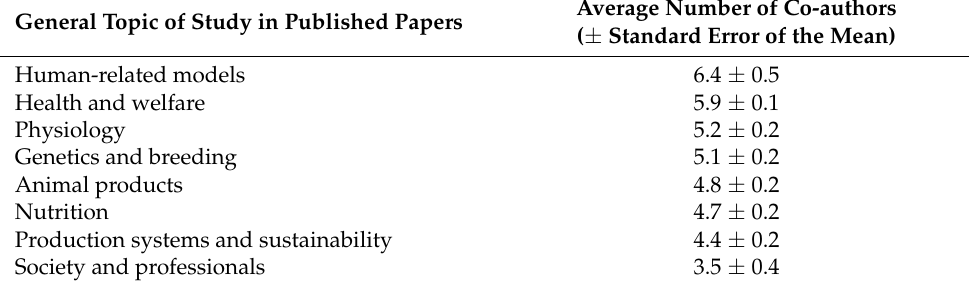
Table 5. Average number of co-authors in papers on sheep and goats published during 1997–2022 from Greece, according to general topic of the